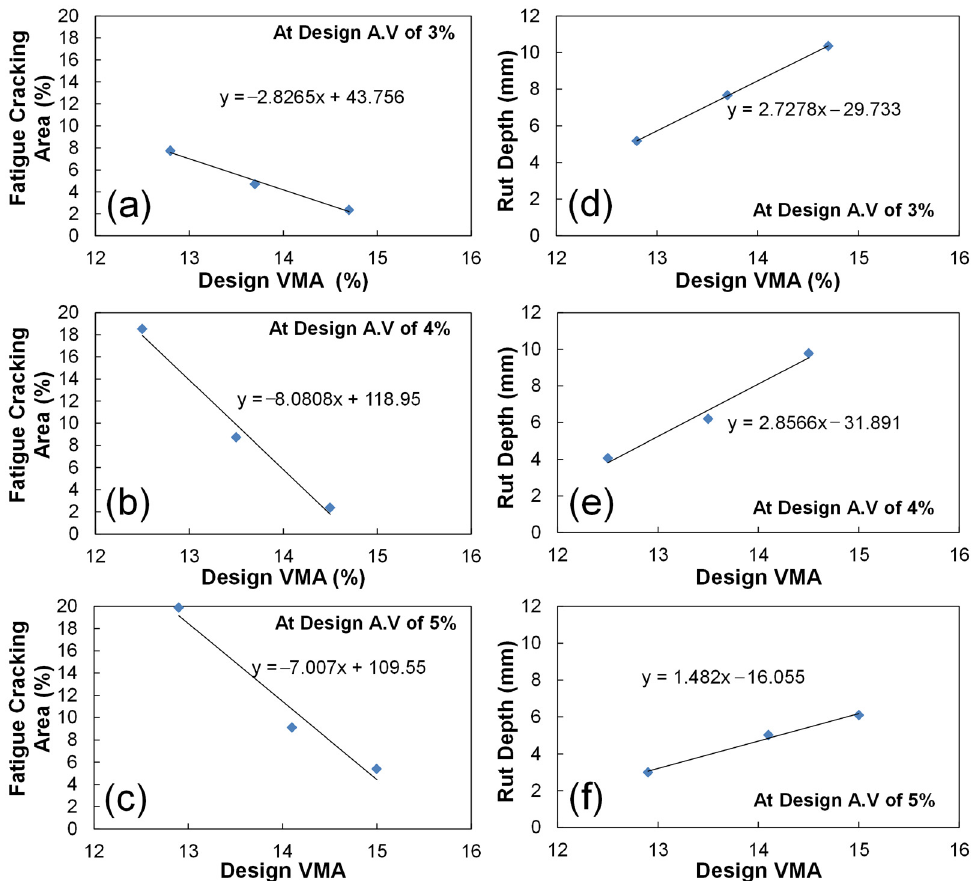
Figure 13. Development of mathematic relationships between the design VMA (%) and predicted performance (fatigue damage area ( a – c ), asphalt rut depth ( d – f )) at design air voids of 3% ( a , d ), 4% ( b , e ), and 5% ( c , f ).